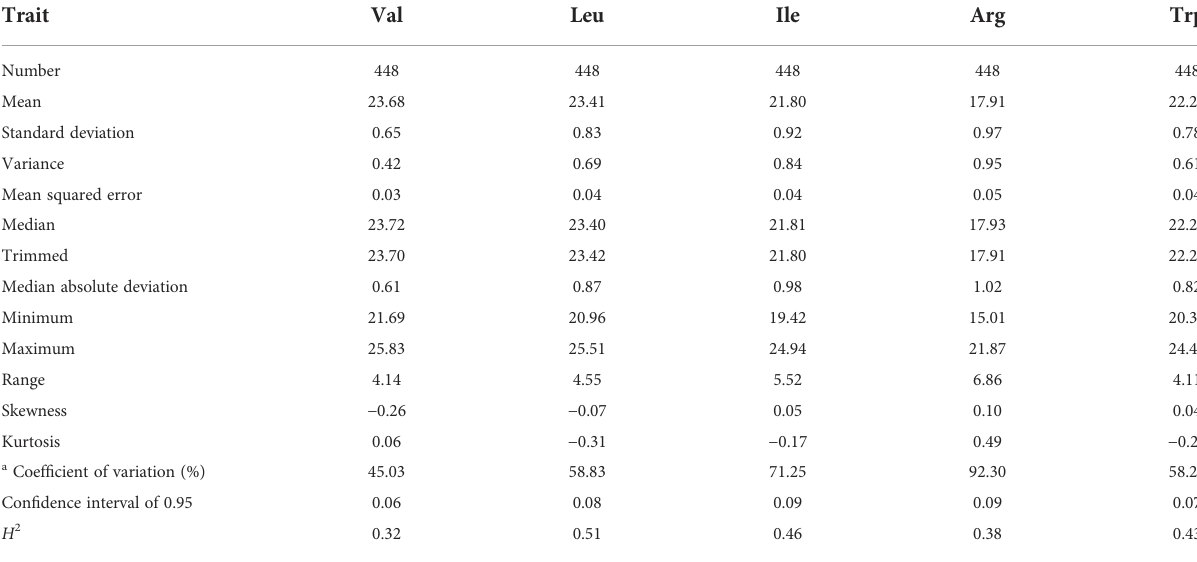
TABLE 1 Descriptive statistics of fi ve FAA content